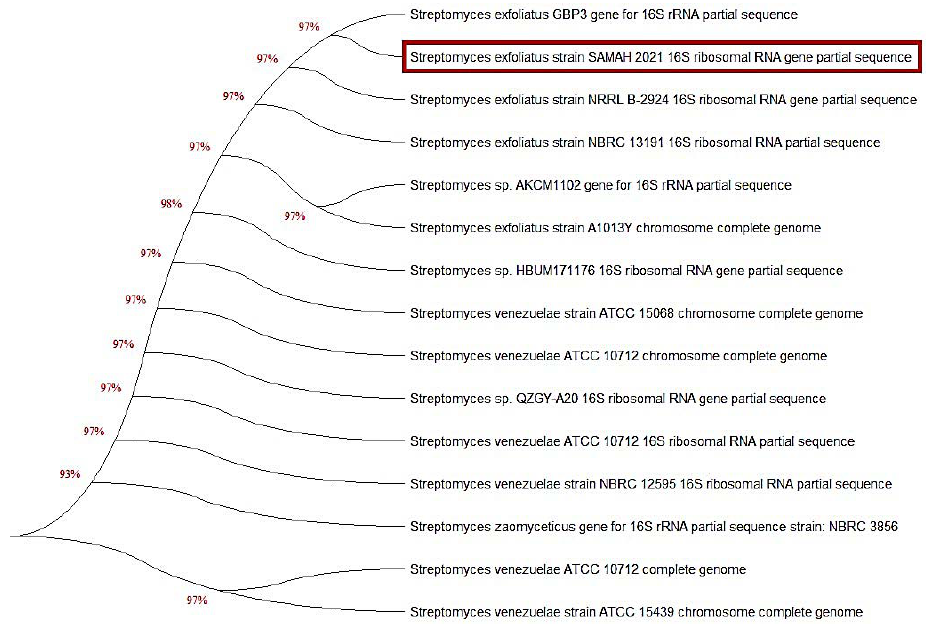
Figure 2. A phylogenetic neighbor ‐ joining tree based on the 16S rRNA gene sequence of the most potent dyes ‐ degrading strain S. exfoliates (marked in orange color) was assembled. The DNA sequence in the current study was deposited on the GenBank under accession number; OL720220 ( S. exfoliatus ). Utilizing MEGA X program, phylogenetic analysis was performed using the neighbor ‐ joining algorithm.